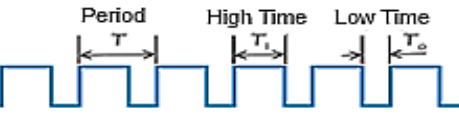
Figure 6. Generator circuit of a PWM signal.